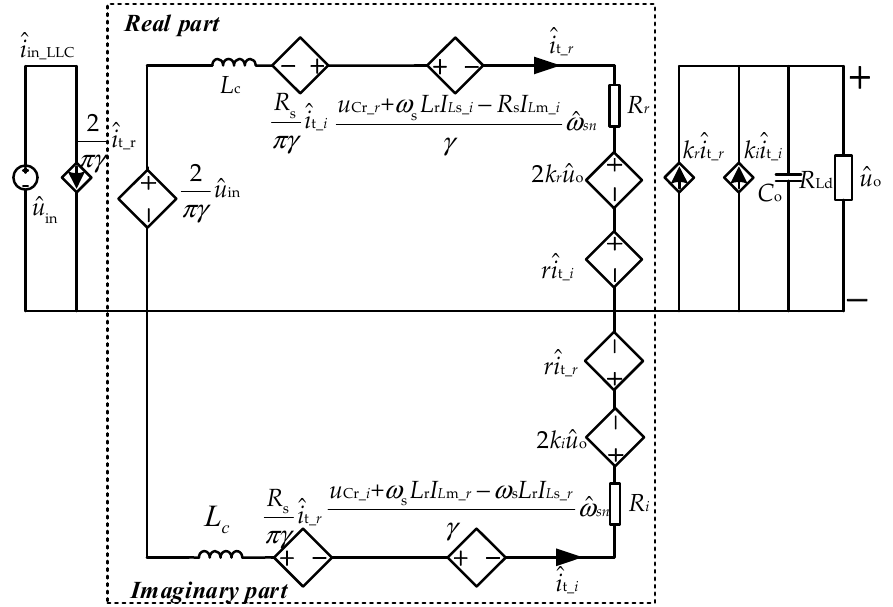
Figure 11. LLC resonant converter third order small signal model.